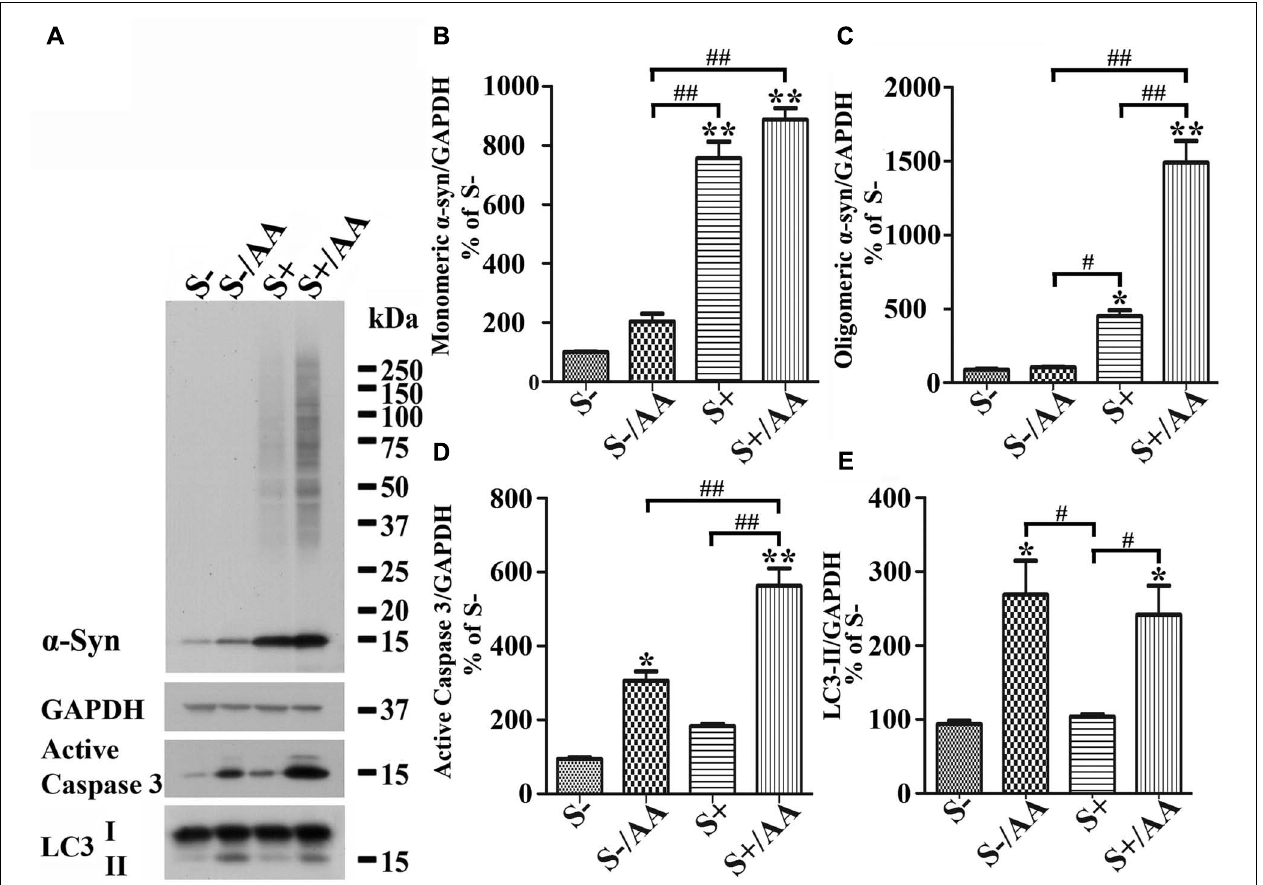
Number sign(s) marked significant differences between two groups linked by bracket ( # p < 0.05, ## p < 0.01). Asterisk(s) indicated significant differences between the treated group and Con0h (* p < 0.05, ** p < 0.01). Our results showed that S + /AA were demonstrated to accumulate much more α -syn than S − /AA. Most of the increase of α -syn observed in S − /AA is monomer, whereas that in S + /AA is oligomers and monomers. The results of immunoblotting also showed that AA exposure heightened the level of LC3-II and active caspase 3 in both S − /AA and S + /AA cultures, but its impacts on caspase 3 was greater for the S + /AA than S − /AA